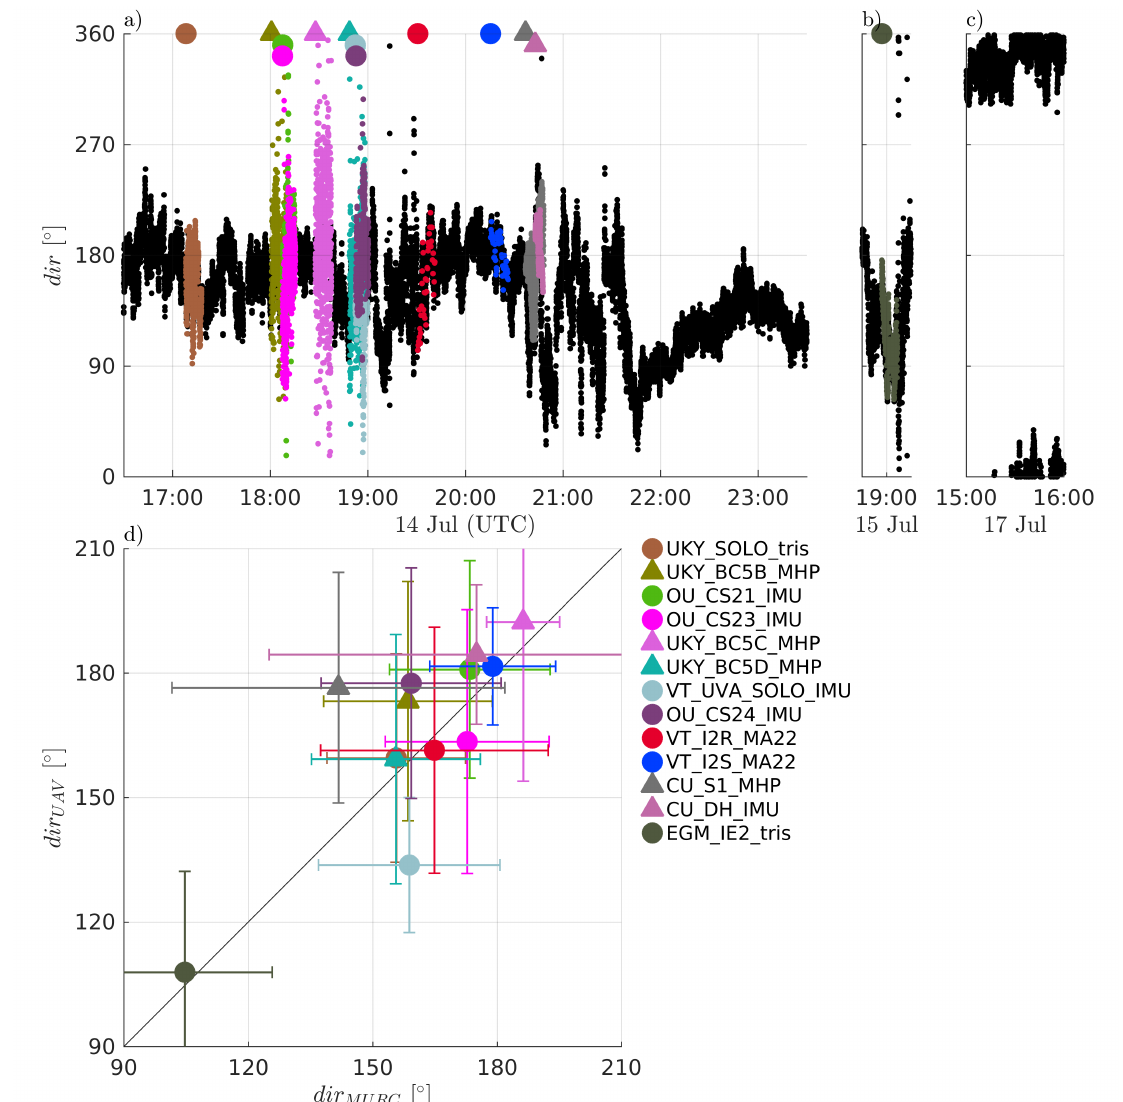
Figure 8. Time series of wind direction measurements (represented as dots for better interpretability) during July 14 ( a ), 15 ( b ), and 17 ( c ) and differences to MURC reference measurements ( d ). The colors and markers follow the same scheme as in Figure